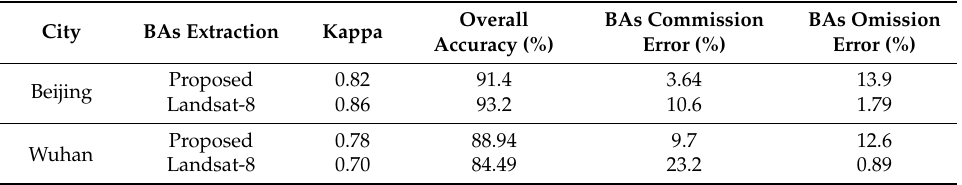
Figure 9. Comparison of Sentinel-1 SAR-based and Landsat-based BAs extraction. ( a , c ) are BAs results (in Red) overlaid on the Landsat-8 OLI/TIRS images (RGB: 6-5-4) of Beijing and Wuhan; ( b , d ) are SAR-based and Landsat-8 based BAs results overlaid on the resampled SAR images. Red: BAs extracted by the two; Yellow: BAs detected by SAR and missed by Landsat-8; Blue: BAs extracted from Landsat-8 and missed by SAR. Table 8. Accuracy comparison of SAR-based and Landsat-based BAs